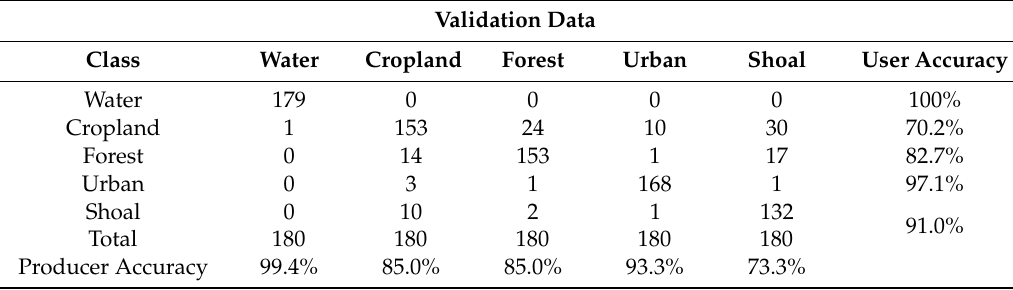
Table 3. Confusion matrix for the 1997 classified imagery.